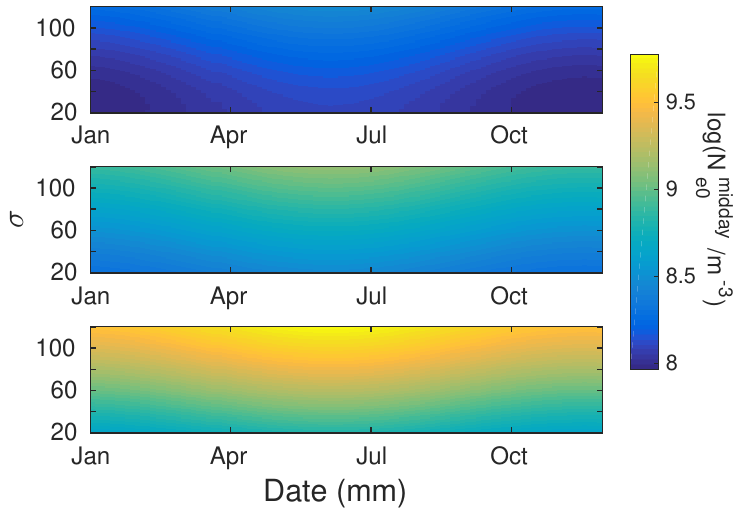
Figure 10. Dependencies of log( N midday /1 m − 3 ) at the altitudes of 70 km (upper panel), 75 km e0 (middle panel), and 80 km (bottom panel) on season and smoothed daily sunspot number σ